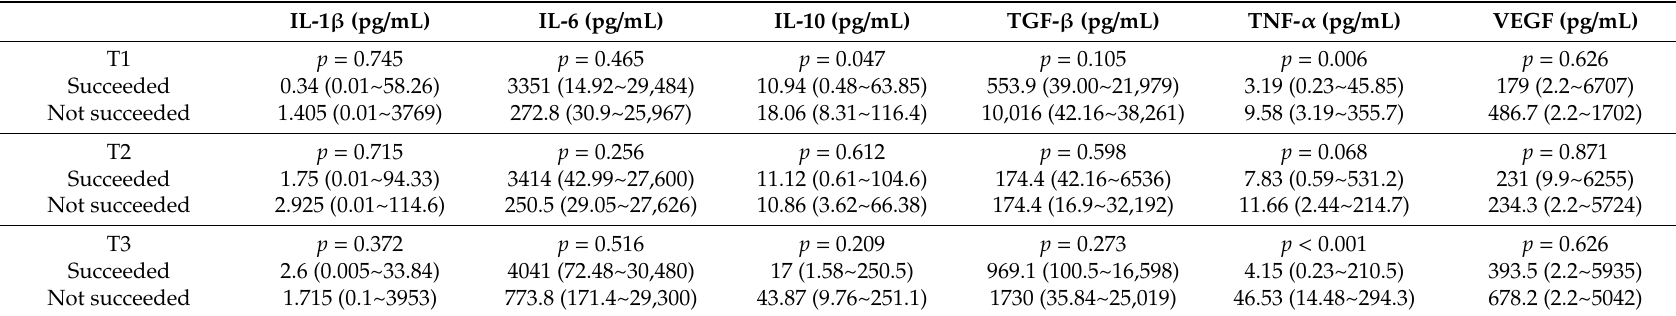
Table 2. Measured pleural fluid cytokine and VEGF levels before pleurodesis (T1), 3 hours after pleurodesis (T2), and 24 hours later before the removal of the intrapleural catheter (T3) were compared between patients who underwent successful pleurodesis ( n = 19) and those that did not ( n =